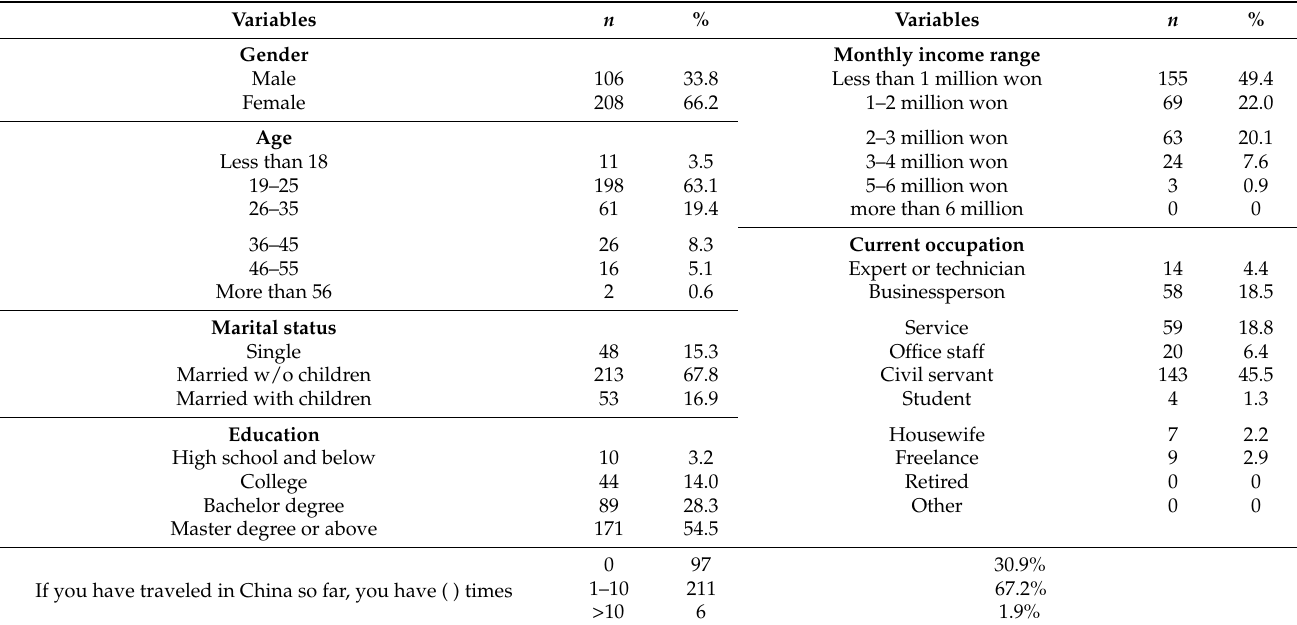
Table 3. Demographic profiles of participants ( n =